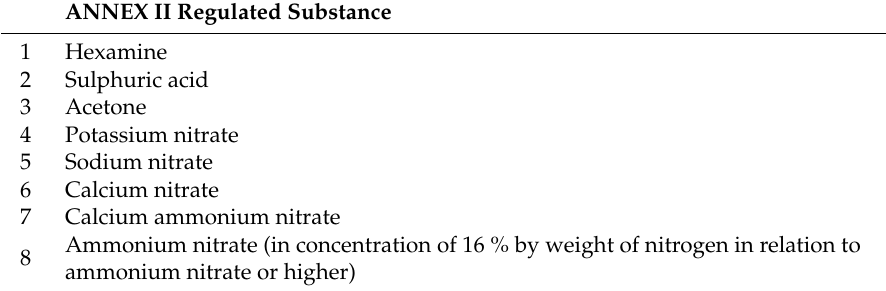
Table 2. Precursors listed in the Annex II of the European Parliament and the Council adopted the Regulation (EU) No. 98/2013 on the marketing and use of explosives precursors on 15 January 2014 [5], which are required to be reported as suspicious transactions when purchased by the